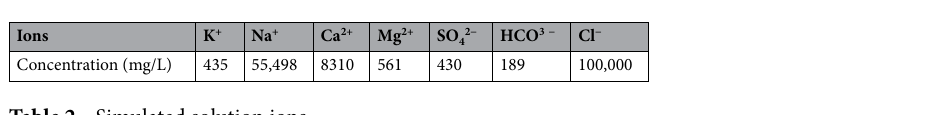
Table 2. Simulated solution